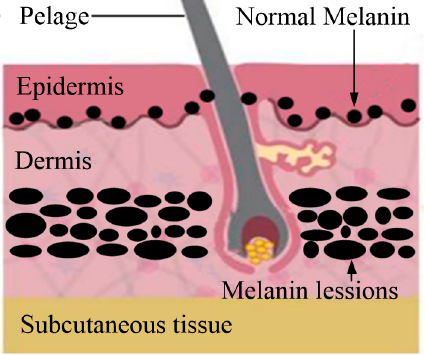
Figure 1. Schematic of the skin structure of Ota’s nevus.